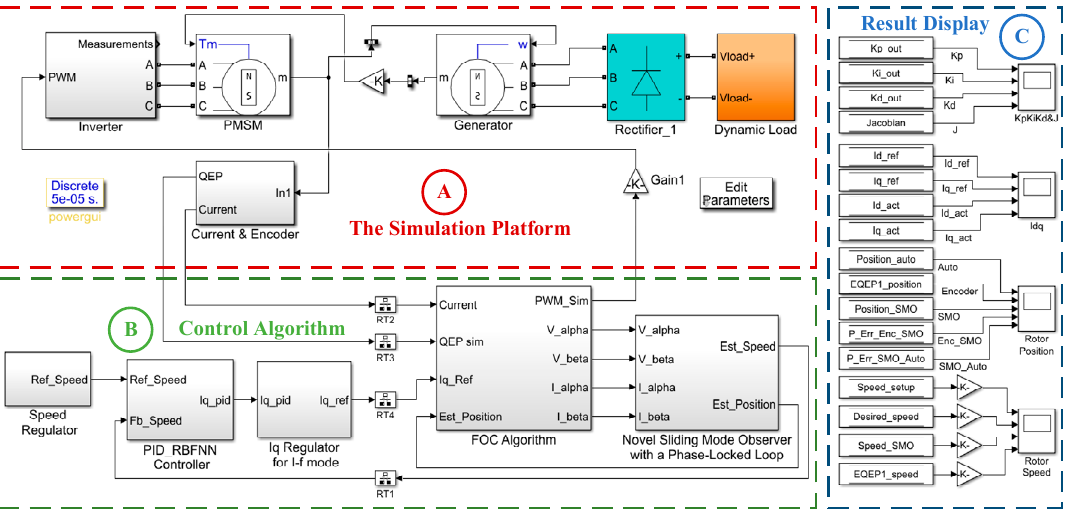
Figure 7. The simulation structure of the sensorless speed control algorithm for the PMSM drive system with a dynamic load system in MATLAB Simulink.